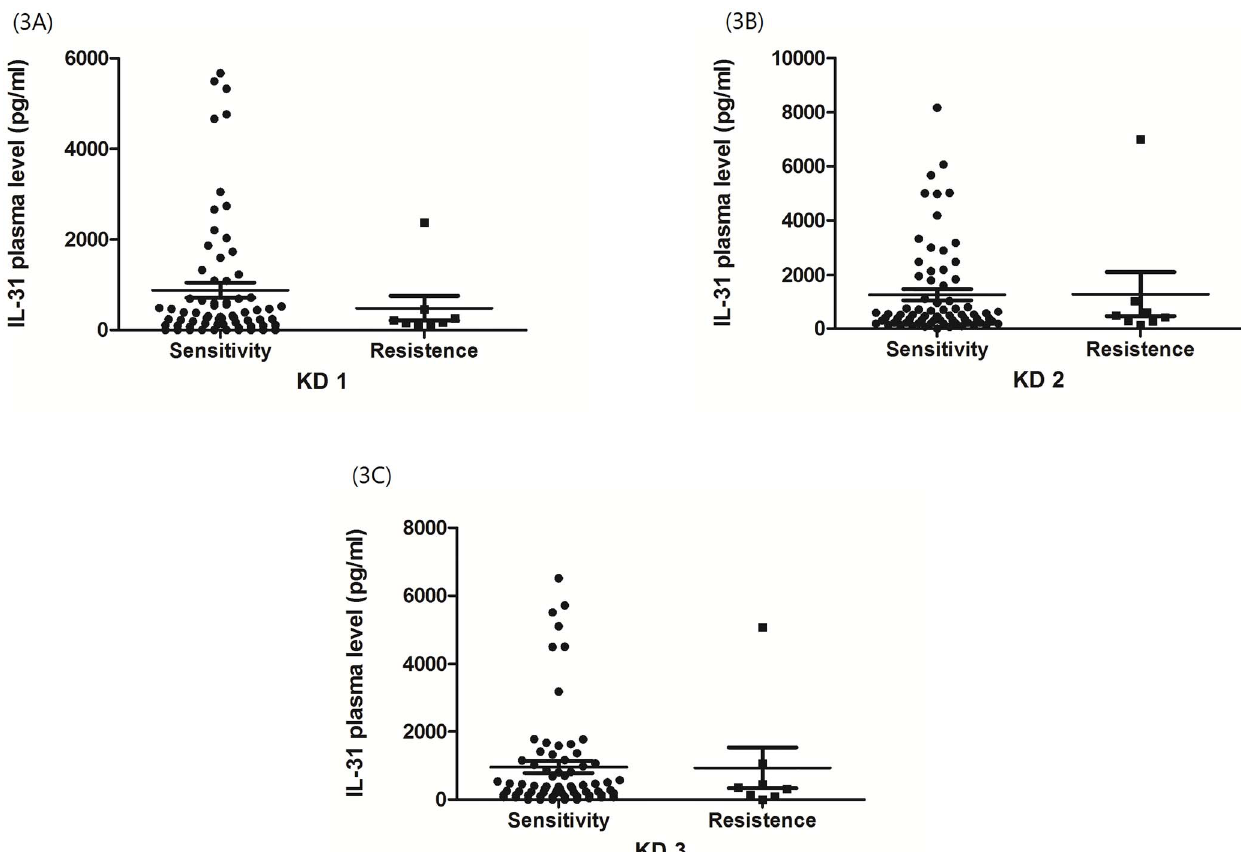
Figure 3. IL-31 levels in KD patients showed no significant association with IVIG resistance. The display (3A) showed no significant difference (880.9 6 166.7 vs. 484.4 6 273.0 pg/ml, p=0.43) in patients before IVIG treatment. Data also showed no significant difference in KD2 (1263.0 6 204.0 vs. 1285.0 6 818.9 pg/ml, p=0.97) (3B) and KD3 (958.7 6 176.4 vs. 938.8 6 602.0 pg/ml, p=0.97) (3C).